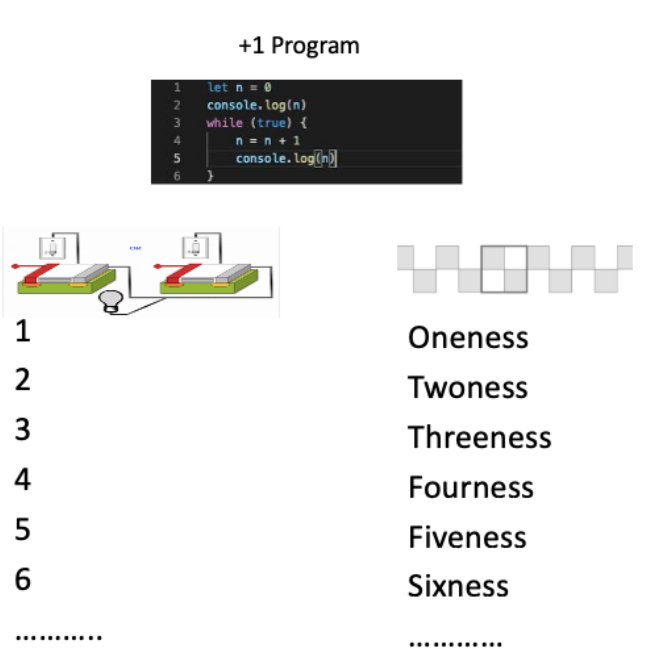
Figure 4. Output of a physical computer ( left ) and output of Platonic computer ( right ) from running a +1 program.